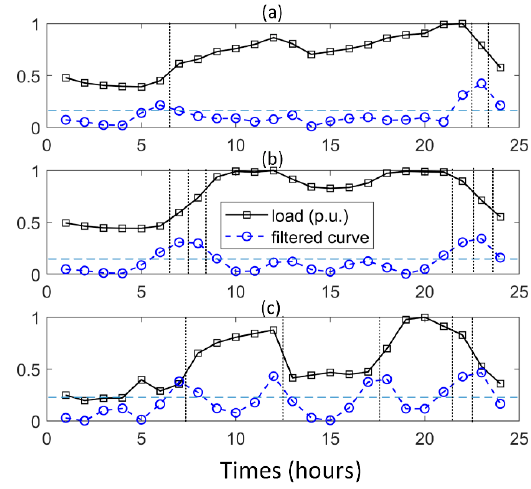
Figure 5. Segmentation of load curves in case 4. Each figure corresponds to segmentation for each curve, i.e., load curve 1 ( a ), curve 2 ( b ) and curve 3 ( c ), then all boundaries shown as vertical dashed lines are combined as separation time points.